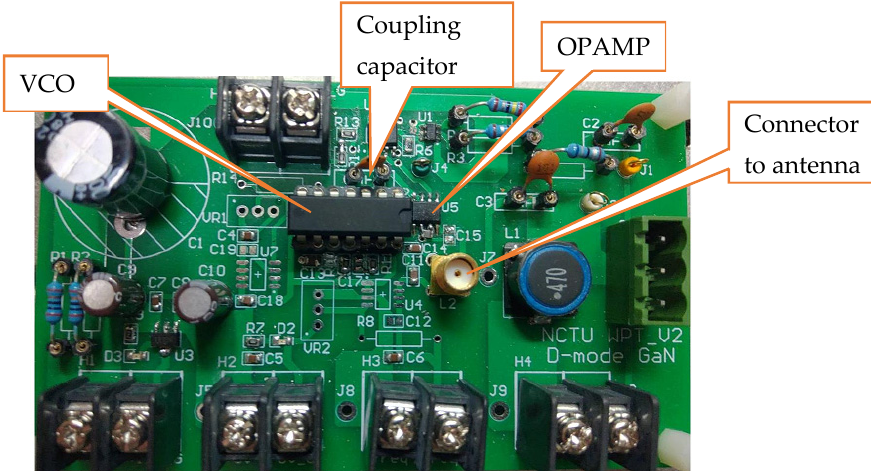
Figure 21. A cCCDA driving circuit board 6.5 cm wide and 11 cm long.